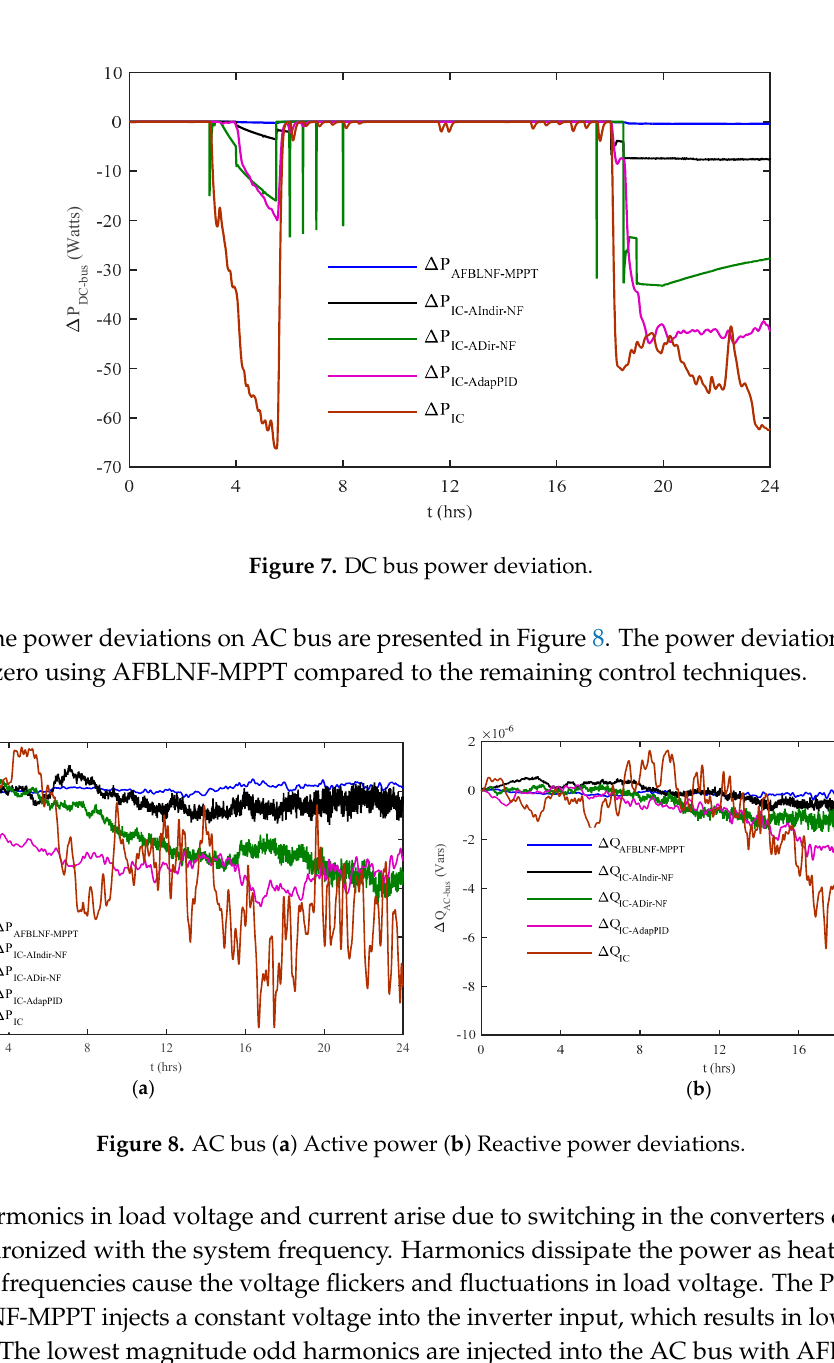
Figure 9. Harmonics of load ( a ) voltage ( b ) current.